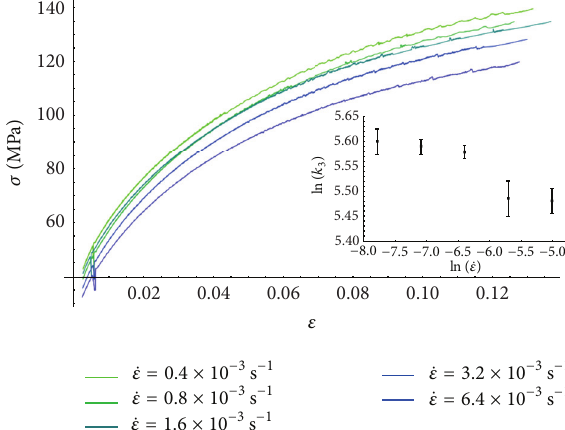
Figure 3: Selected tensile curves at different strain rates showing the inverse strain rate sensitivity and PLC effect (serrated flow). The inset presents a ln-ln plot of ̇𝜀 versus 𝑘 0 in formula (1); the slope of the plot corresponds to the exponent ] in formula (18); error bars represent the standard deviation on ln 𝑘 0